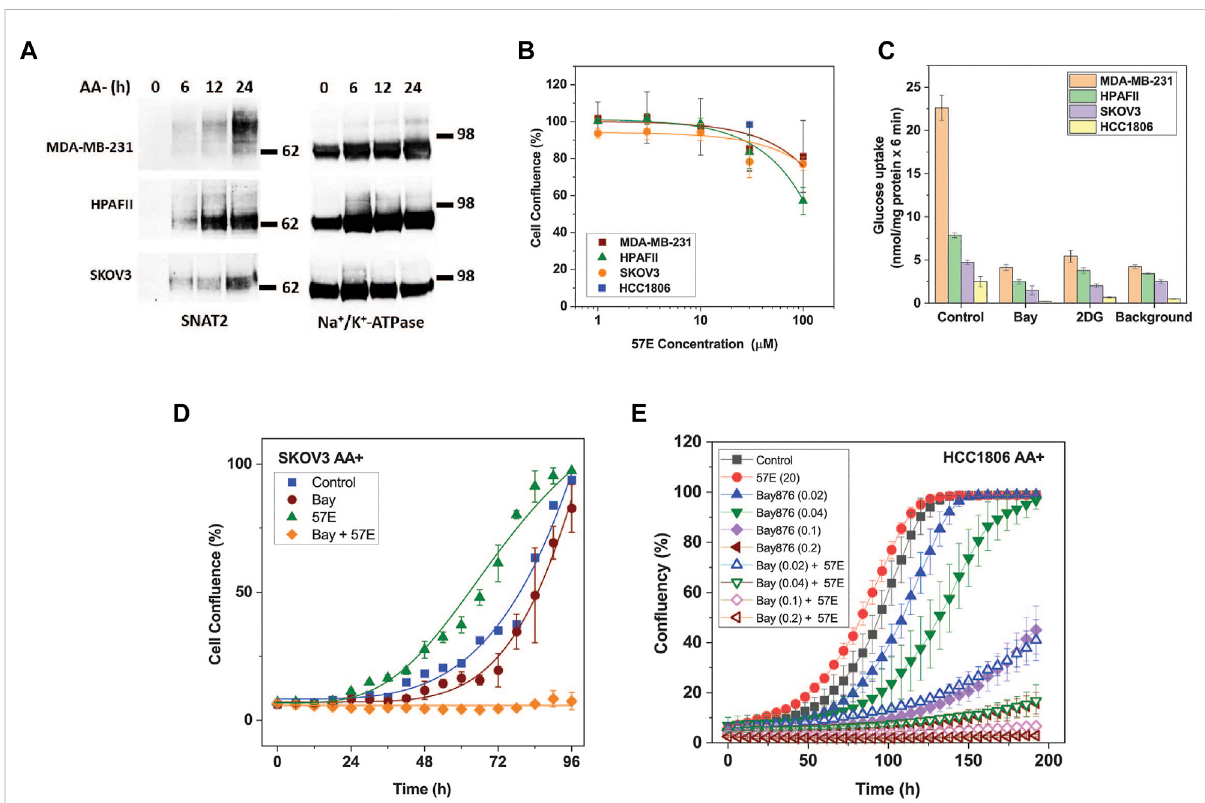
FIGURE 6 Effect of compound 57E on cancer cell growth. The effect of compound 57E on the growth of HPAFII, SKOV3, HCC1806, and MDA-MB- 231 cells was tested to assess its cytotoxic effects. (A) Surface expression of SNAT2 was evaluated by surface biotinylation and western blotting in freshmediaandafteraminoacidstarvationofupto24 h.Na + /K + -ATPasewasusedasaloadingcontrol.ForHCC1806cellsseeFigure1A. (B) Titration ofcompound57Eanditseffectongrowth ratesofHPAFII,SKOV3, HCC1806(30 μ Monly)and MDA-MB-231 cells. Cellswereseeded onto96- well plates at 3000 cells cells/well and allowed to attach for 24 h, after which growth medium in the absence and presence of increasing concentrations of compound 57E was added. When control wells reached approximately 90% con fl uence, each well was analysed by an IncuCyte system to quantify con fl uence. The mean con fl uence at various concentrations was normalised to the control and was plotted ± STD (n = 6). (C) Glucose uptake in MDA-MB-231, HPAFII, and SKOV3 cells. Cells were incubated with 100 µM [ 14 C]glucose for 6 minutes in the presence or absence of 1 µM Bay-876or 10 mM 2-Deoxyglucose (2-DG). A background control consisting of 10 mM non-labelled glucosewas included. Data are shown as the mean ± STD (n = 3). (D) Continuous live-cell imaging of SKOV3 cells exposed to 1 µM Bay-876 and 20 µM compound 57E alone and